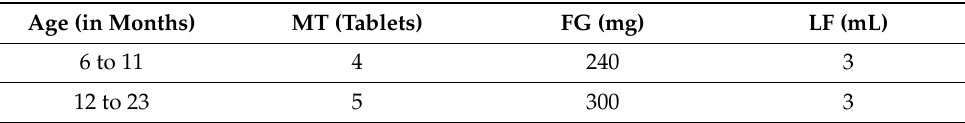
Table 1. Dosage of minitablets (MT), fine granules (FG), and liquid formulations (LF) for each age group.